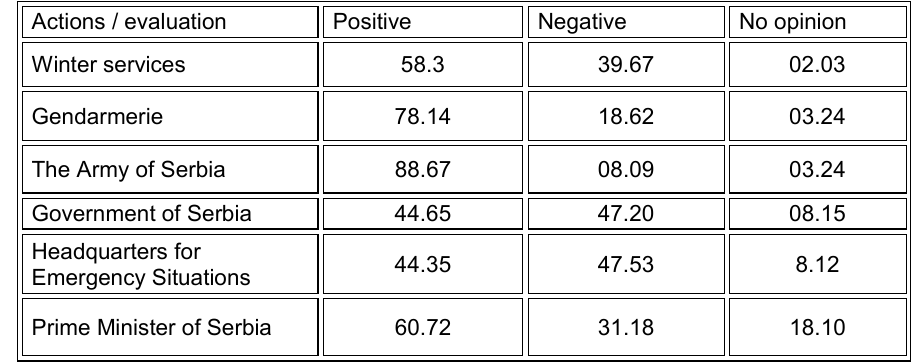
Table 3 – Public opinion on the actions of the Civil Defence entities Таблица 3 – Мнение граждан о мероприятиях представителей Гражданской